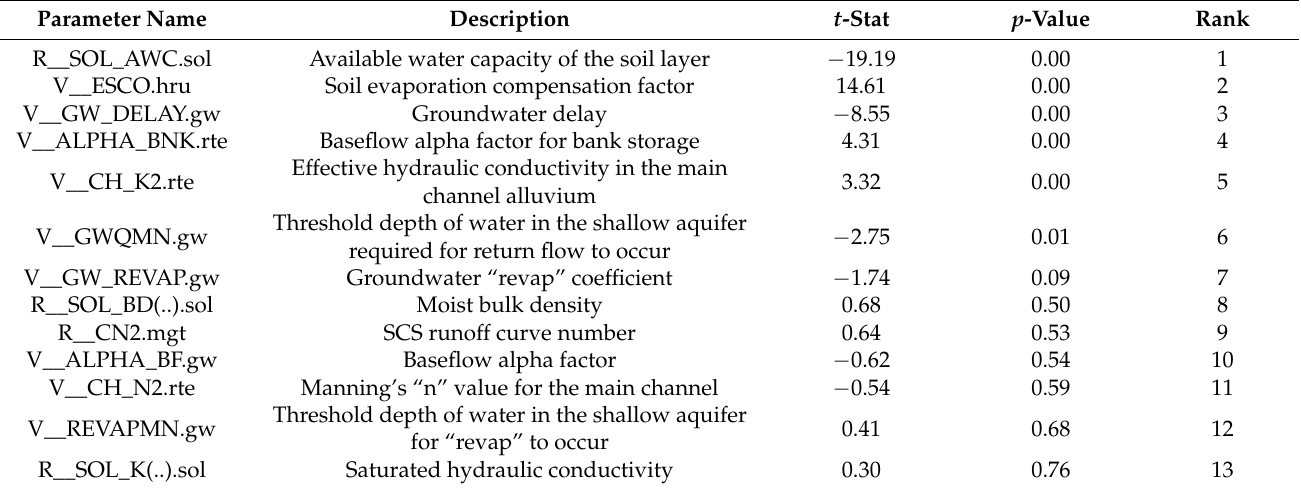
Table 4. Sensitive parameters with t-stat and p